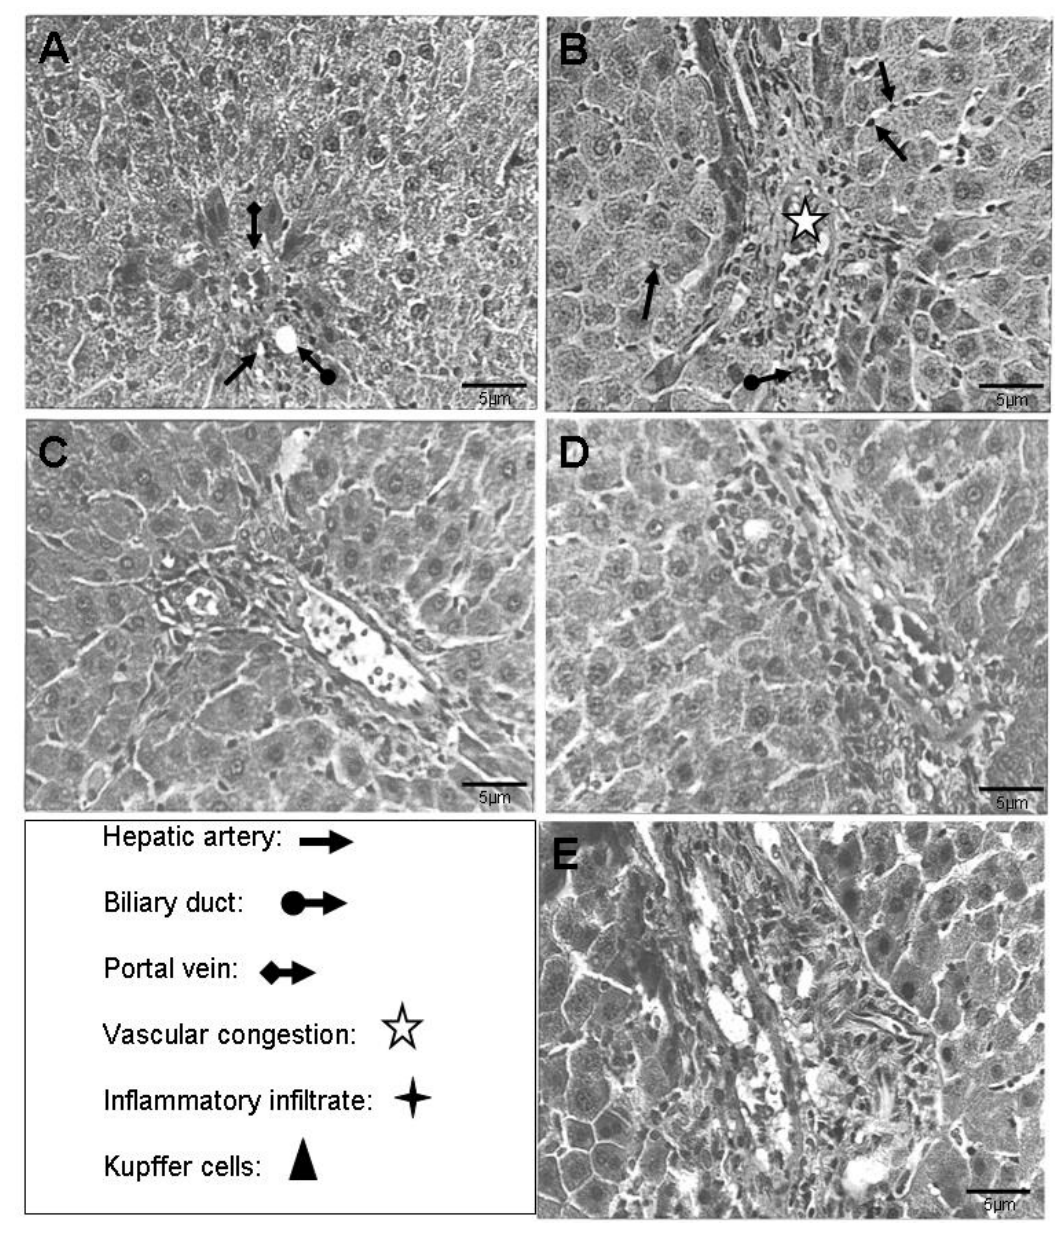
Figure 2 . Histological analysis. (A) Photomicrograph of hepatic tissue from the control group (HE, 400x). See hepatic artery ( ), biliary duct ( ), portal vein ( ). (B) Photomicrograph of hepatic tissue 6 hours after venom injection (100 μ g/kg) (HE, 400x). Observe vascular congestion ( ), inflammatory infiltrate ( ) and increased density of Kupffer cells ( ). (C) Photomicrograph of hepatic tissue 12 hours after venom injection (100 μ g/kg) (HE, 400x). A few inflammatory cells and plate hepatocytes. (D) Photomicrograph of hepatic tissue 6 hours after venom injection (200 μ g/kg) (HE, 400x). Dense inflammatory infiltrate and portal vein congestion. (E) Photomicrograph of hepatic tissue 12 hours after venom injection (300 μ g/kg) (HE, 400x). Damaged hepatic vascular system showing high inflammatory infiltrate; hepatocyte